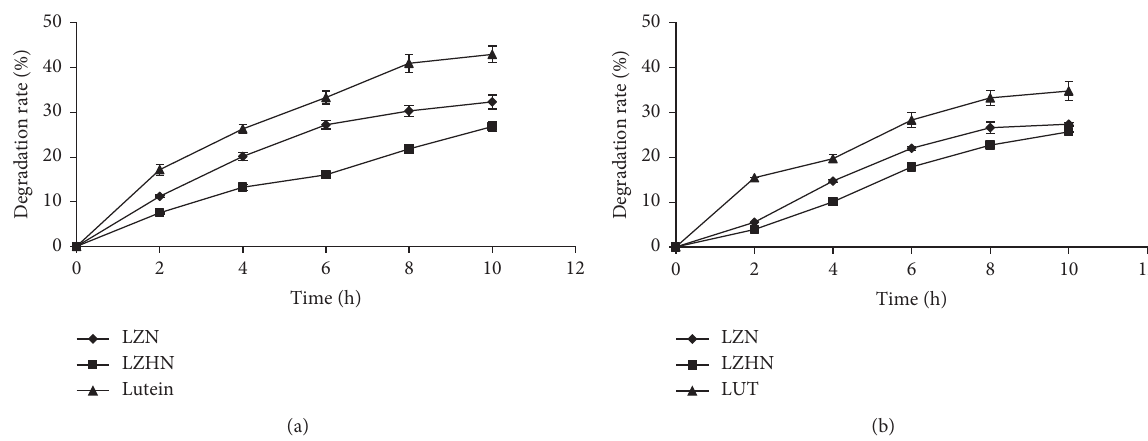
Figure 6: Lutein degradation rate of free lutein, LZN, and LZHN during digestion in SGF (a) and in SIF (b) for 10